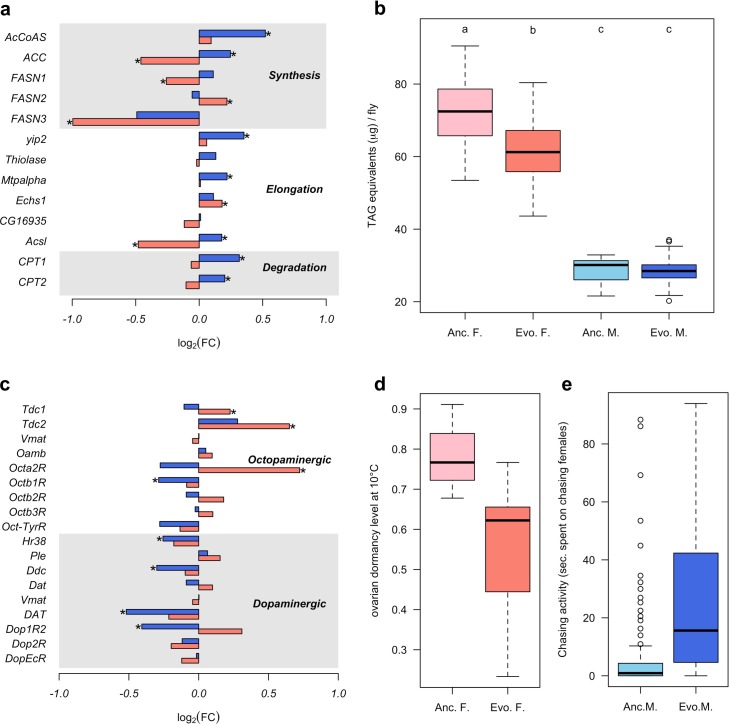
Sex-specific phenotypic evolution.(a and c) Genes involved in fatty acid metabolism and monoaminergic neural signaling evolve in response to high temperature. The evolutionary changes in males (blue bar) and females (red bar) are shown on log2 scale. Statistical significance (FDR < 0.05) is indicated with *. For both set of genes, the evolution is largely sex-specific or even sexually discordant. (b) Level of triglycerides, the main constituent of body fat data from Barghi et al. (2019). Evolved females have significantly lower fat content than the ancestral ones. No significant difference is found in males. Two-way ANOVA and Tuckey’s HSD test. (d) Ovarian dormancy incidence at 10°C in ancestral and evolved females. Evolved females have a lower dormancy incidence than ancestral ones (Wilcoxon’s test, W = 1.5, p=0.028). (e) Time males chasing females. Evolved males spent significantly more time chasing females (Wilcoxon’s test, W = 1323.5, p<0.001).